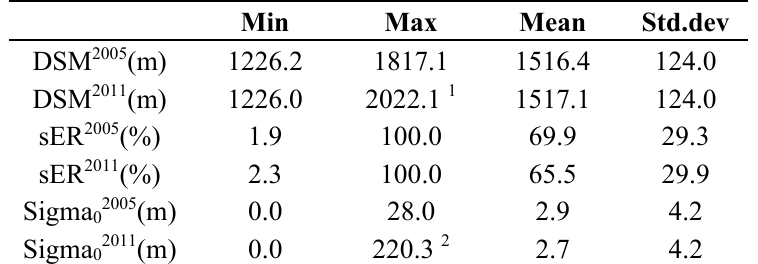
Table 2. Minimum, maximum, mean, standard deviation of DSM, sER, and Sigma 0 in the different epochs.